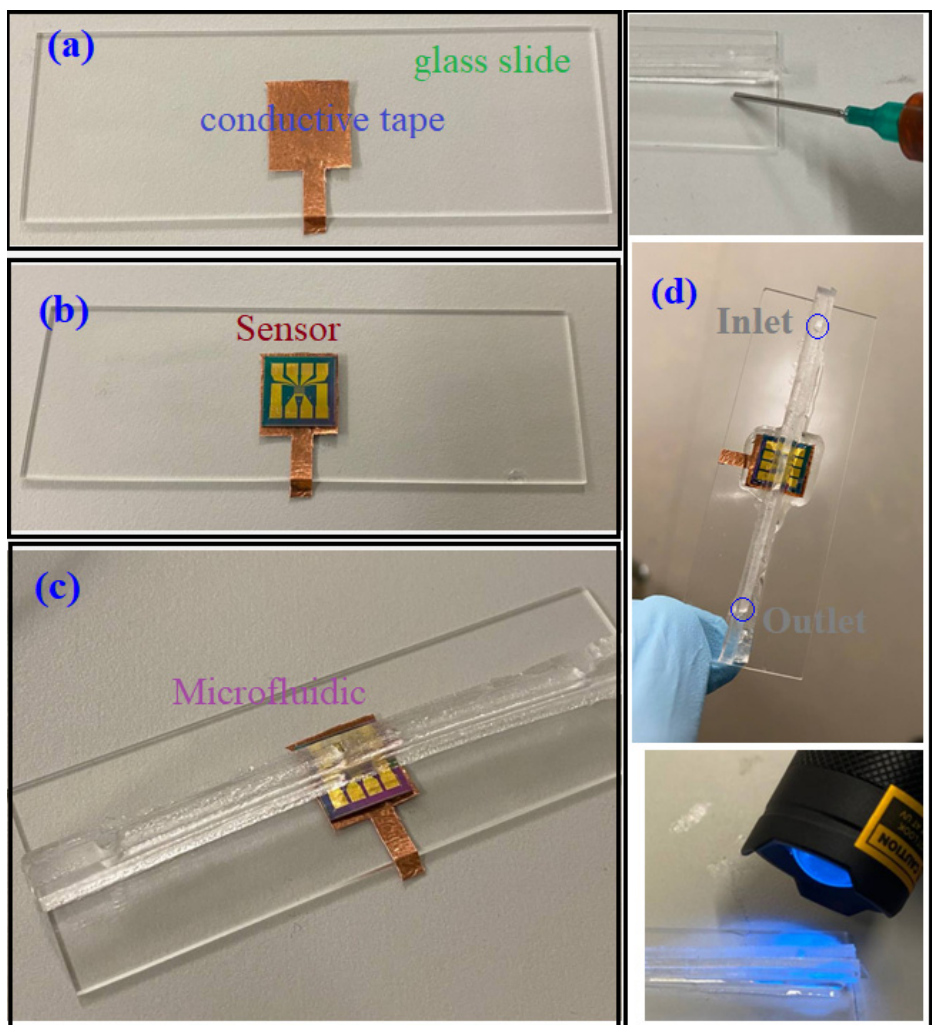
Figure 6. Bonding process of the microfluidic channel on the chip. ( a ): A copper conductive tape was utilized to create the back ‐ gate connection on the glass slide. ( b ): the sensor was put on the sensor. ( c ): after heating the microfluidic, it was aligned with the chip under a microscope. ( d ) filling the gap underneath the microfluidic with UV curable glue and applying UV light to make the structure strongly bonded.